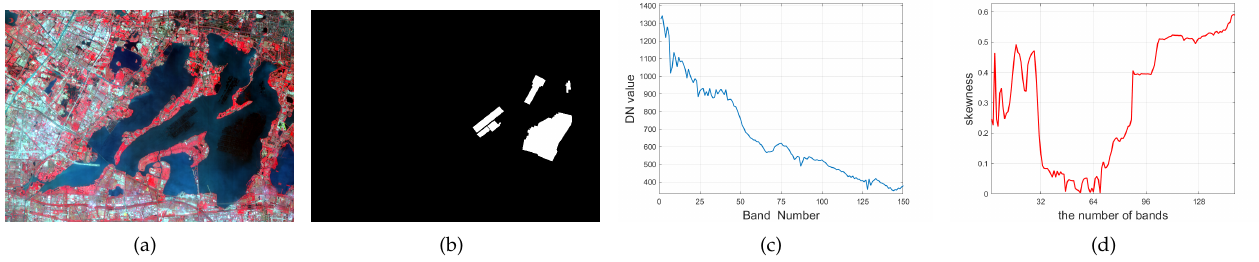
Figure 6. For the YC lake data with 150 bands, ( a ): the false color image (R: 860.88 nm, G: 651.31 nm, B: 548.66 nm); ( b ): the groundtruth image; ( c ): the selected spectrum of the target of interest; ( d ): the skewness curve as a function of L , ranging from 2 to 150.